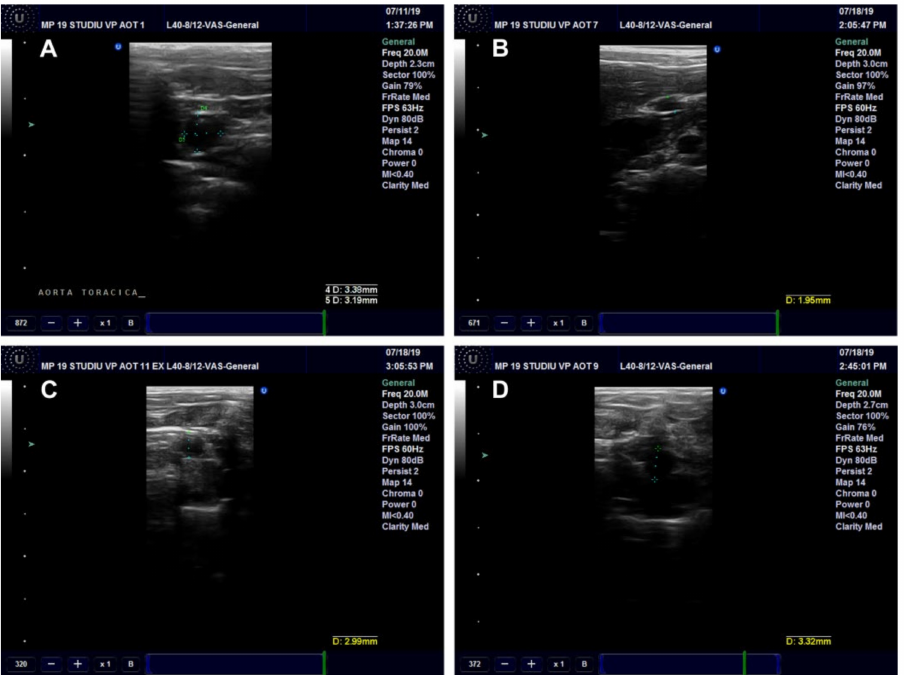
Figure 11. Ultrasound examination of the descending aorta diameter in rats with 9 months of HFD, the last month with oral administration of: 0.9% saline solution for Control ( A ) and HFD ( B ) groups, Cornus mas L. extract for HFD + CM group ( C ) and gold nanoparticles functionalized with bioactive compounds from Cornus mas L. extract for HFD + AuNPsCM group ( D ).